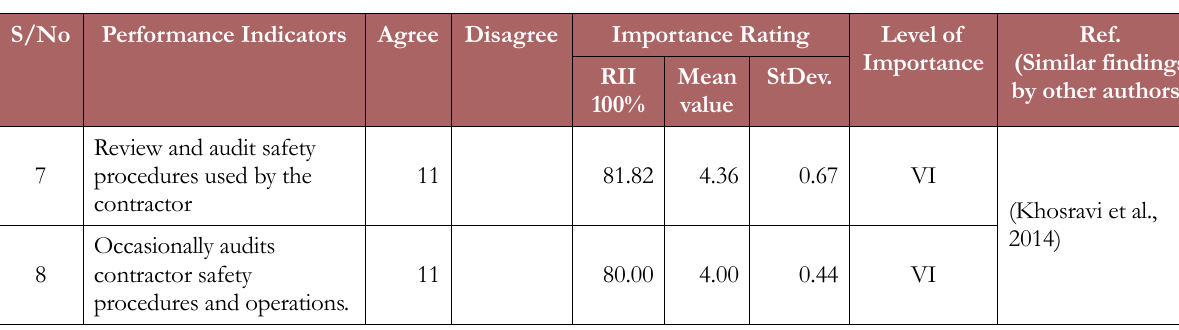
Table 9. Key Performance Indicators for Investigation and Reporting of